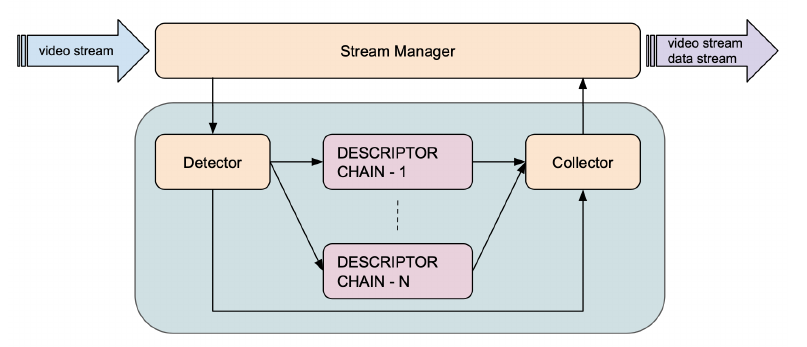
Figure 3. Processing pipeline. A processing pipeline is composed essentially of: at least one Detector, one or more Descriptor Chain (not mandatory), one for each feature to be extracted, and a Collector.